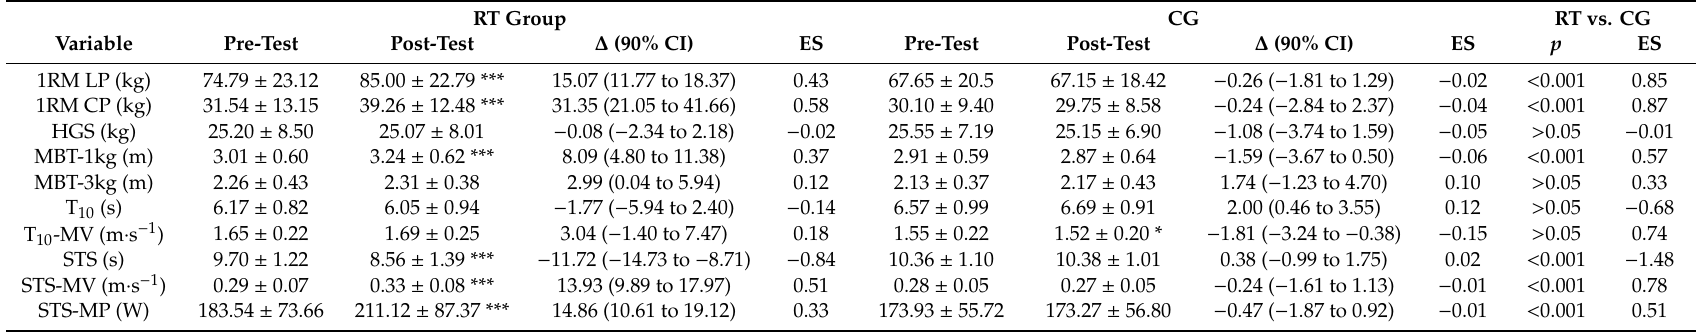
Table 3. Changes in strength-related variables from pre- to post-test in the resistance training group and CG (mean ± SD). RT Group CG RT vs.